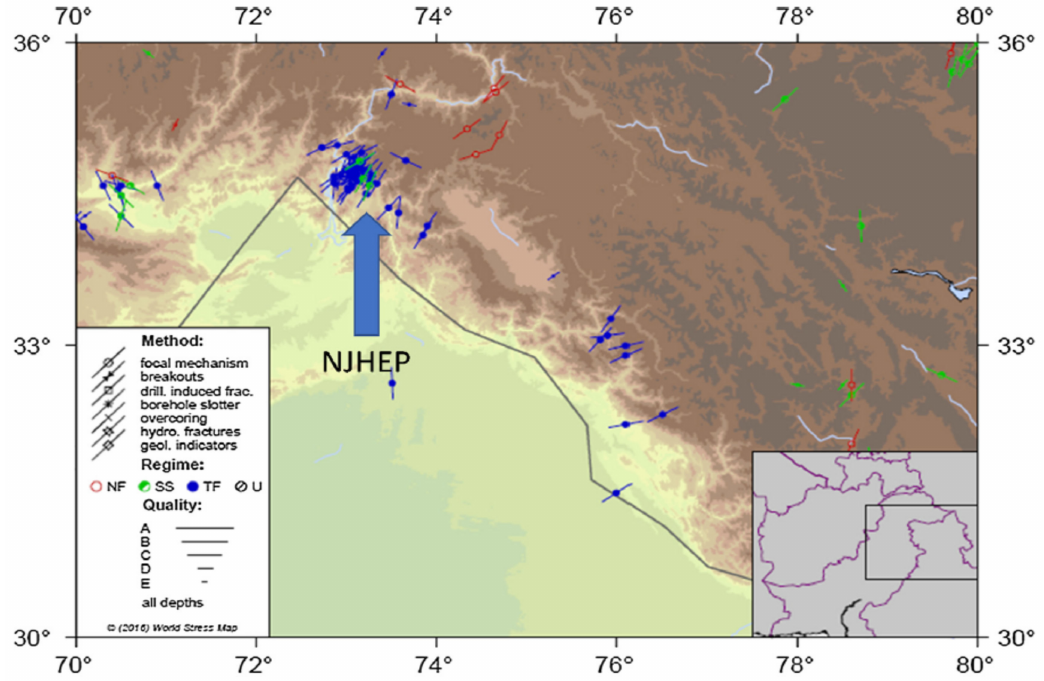
Figure 4. Stress conditions in the project area, obtained using the World Stress